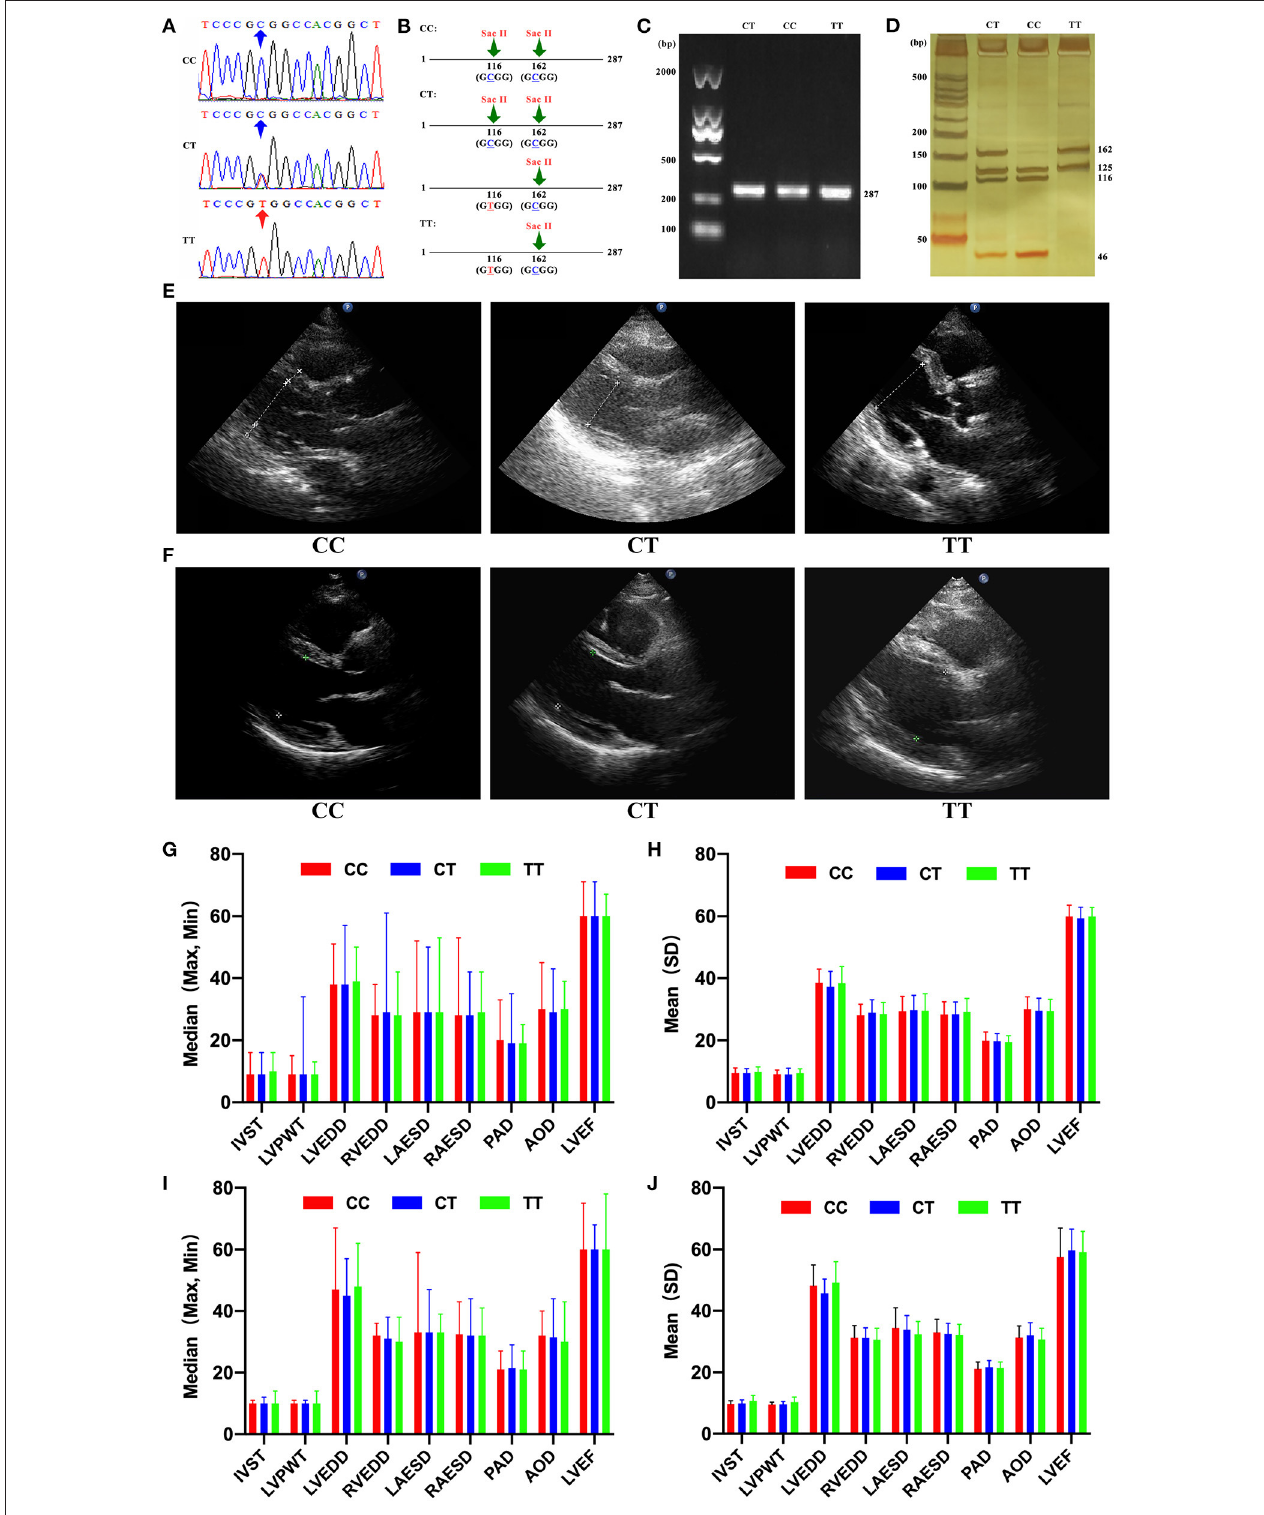
FIGURE 1 | (A) DNA sequencing of ataxia-telangiectasia-mutated ( ATM ) gene with different genotypes of single nucleotide polymorphism (SNP) rs189037. (B) ATM promoter region contains two SacII restriction enzyme sites, and one of them is present in SNP rs189037 (C/T) only when T → C institution at nucleotide 116 occurs. (C) Amplification products (287 bp) of ATM gene stained with gelgreen on a 1% agarose gel. (D) Polymerase chain reaction products digested with SacII and